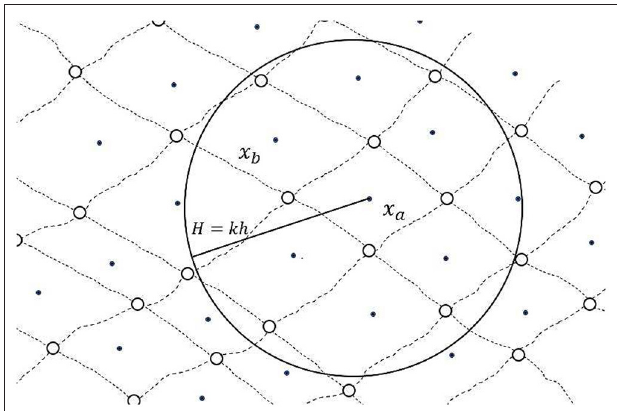
FIGURE 1 | Schematic drawing illustrating the SPH interpolation in two-space dimensions ( n = 2). The circle of radius H = kh defines the compact support of the kernel function W ( | x a − x b | , h ) centered at the position x a of the observation particle a . Although the particles are depicted as point-like masses, their geometrical shape corresponds to an irregular rectangular cell of area m b /ρ b . Due to the Lagrangian nature of SPH, the rectangles deform during the evolution. However, they do not overlap and do not have empty interstices between them, which is consistent with the requirement that m b /ρ b 6=